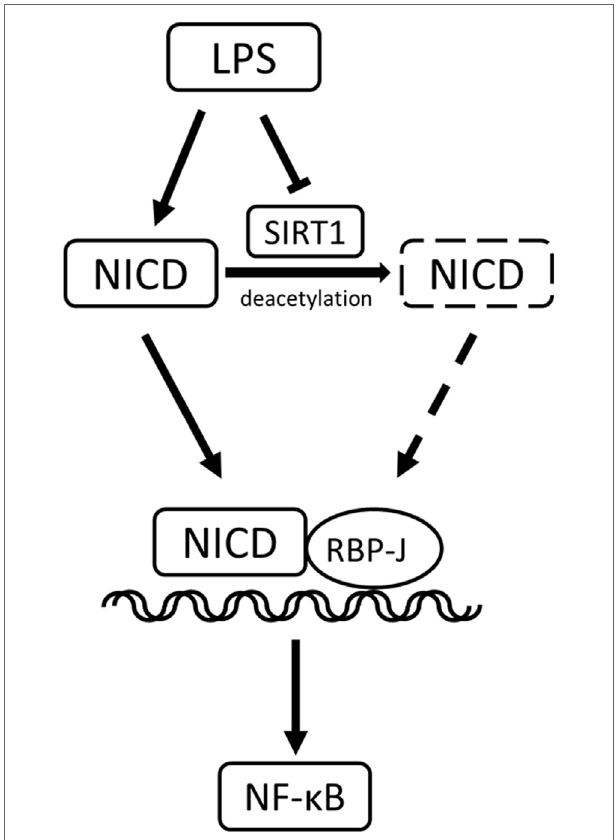
FigUre 9 | Sirt1-Notch interaction in lipopolysaccharide (LPS)-induced macrophages. In LPS-induced inflammation, SIRT1 was suppressed, and Notch signaling was activated. SIRT1 caused the deacetylation of intracellular domain of Notch (NICD), which led to NICD degradation and inhibition of Notch signaling. The inactivation of Notch signaling reduced the activation of the NF- κ B pathway in